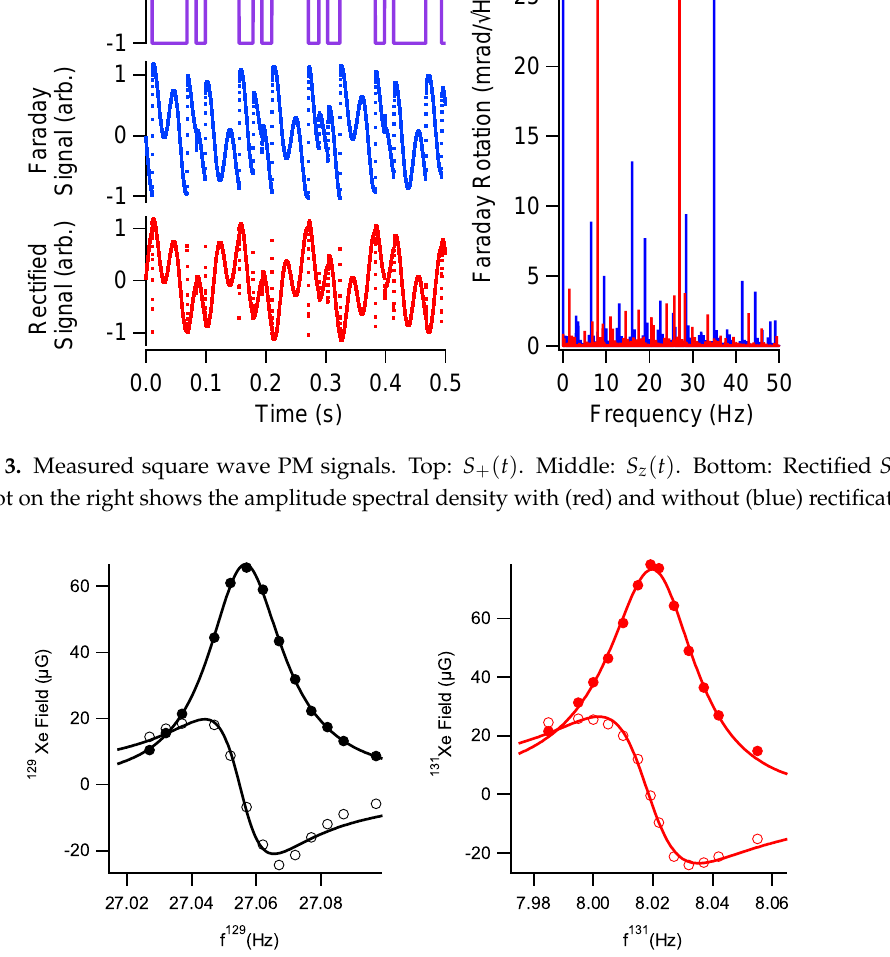
Figure 4. Measured NMR lineshapes of each species. Filled circles are K x , open circles are K y , and lines are Lorentzian